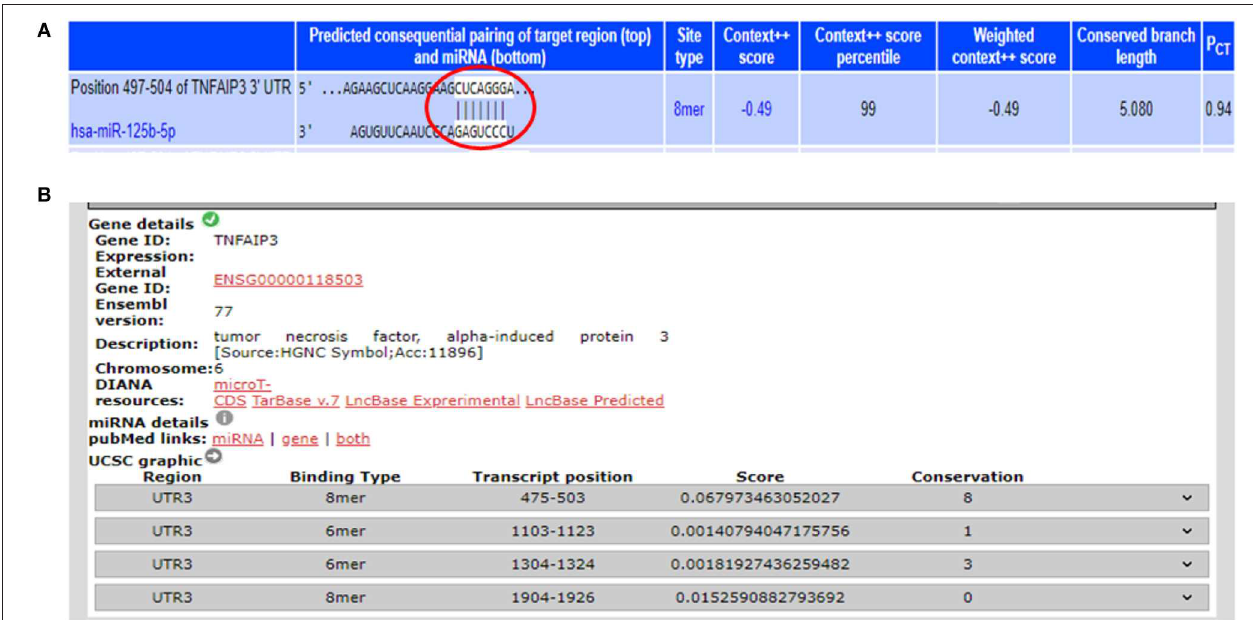
FIGURE 1 | Binding sites in 3 ′ UTR of A20 for miR-125b. (A) 3 ′ UTR of A20 contains binding sites for miR-125b-5p at position 497–504 as shown by target scan (http://www.targetscan.org/cgi-bin/targetscan/vert_72/view_gene.cgi?rs=ENST00000237289.4&taxid=9606&showcnc=0&shownc=0&shownc_nc=&showncf1=& showncf2=&subset=1#miR-125-5p). (B) miR-125b binding sites within the 3 ′ UTR of A20 were also shown by DIANA-microTCDS (http://diana.imis.athena-